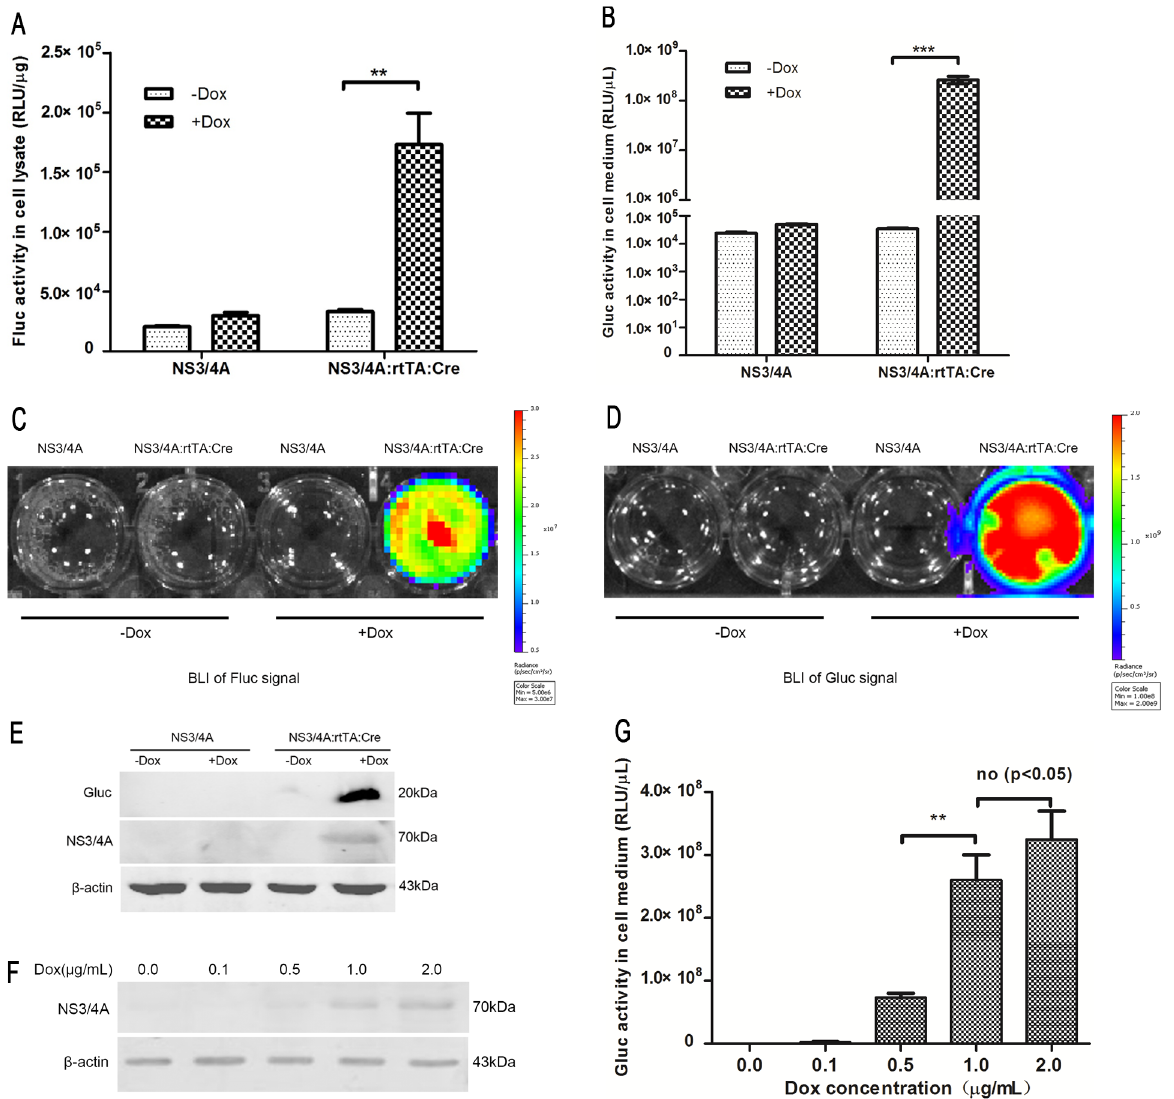
Fig 2. Verification of the functionality of the pBI-NS3/4A plasmid in vitro . (A) The pBI-NS3/4A plasmid was co-transfected into CHO cells with pTet-On- rtTA and pBI-Cre or pBI-NS3/4A alone as a control. The cells were treated with Dox (l μ g/mL) at 6 h after transfection and harvested 48 h after transfection. Cell lysates were measured for Fluc activity. (B) Gluc activity was measured in the culture medium. (C) BLI was used to assess Fluc signals in the co- transfected cells. To accomplish this, 100 μ L D-luciferin (1 mg/mL in PBS) was added to the cells, and they were then scanned using an IVIS Imaging System. (D) BLI was used to assess Gluc signals in the culture medium of the co-transfected cells. To accomplish this, 100 μ L coelenterazine-SOL (100 μ M) was added to the culture medium, and the mixture was then scanned using an IVIS Imaging System. (E) A representative western blot. Samples of culture medium from the co-transfected cells were concentrated and subsequently analyzed using a rabbit anti-Gluc antibody. Cell lysates from the co-transfected cells were analyzed using a mouse anti-NS3/4A antibody. (F) The co-transfected cells were induced with various concentrations of Dox (0.l, 0.5, l, and 2 μ g/ mL). NS3/4A protease expression in the co-transfected cells was analyzed via western blotting. (G) Samples of the culture medium from the co-transfected cells were assessed using a Gluc activity